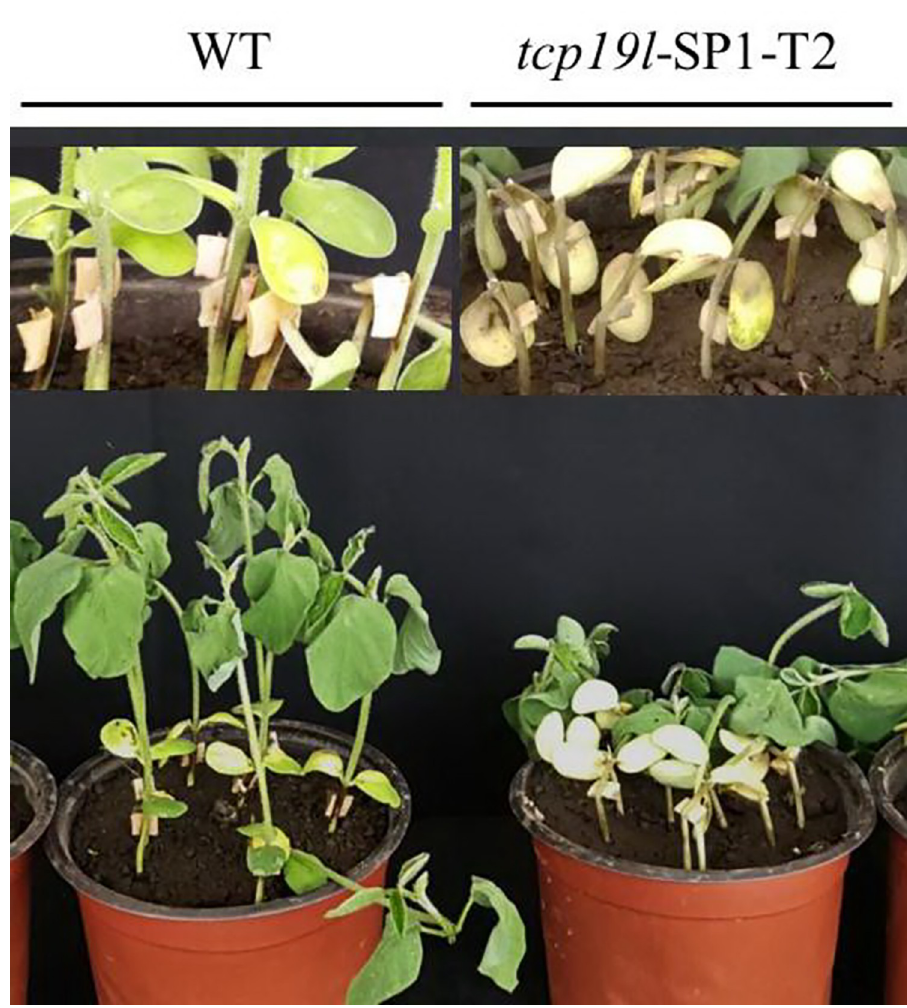
Fig 6. Disease symptoms on the hypocotyls of T2 tcp19l mutants and WT treated with P . sojae after 3 days. WT, wild-type soybean plant. tcp19l -SP1-T2, 2-bp deletion mutants, the progeny of T1 tcp19l mutants tcp19l -SP1-T1#02.03 and tcp19l